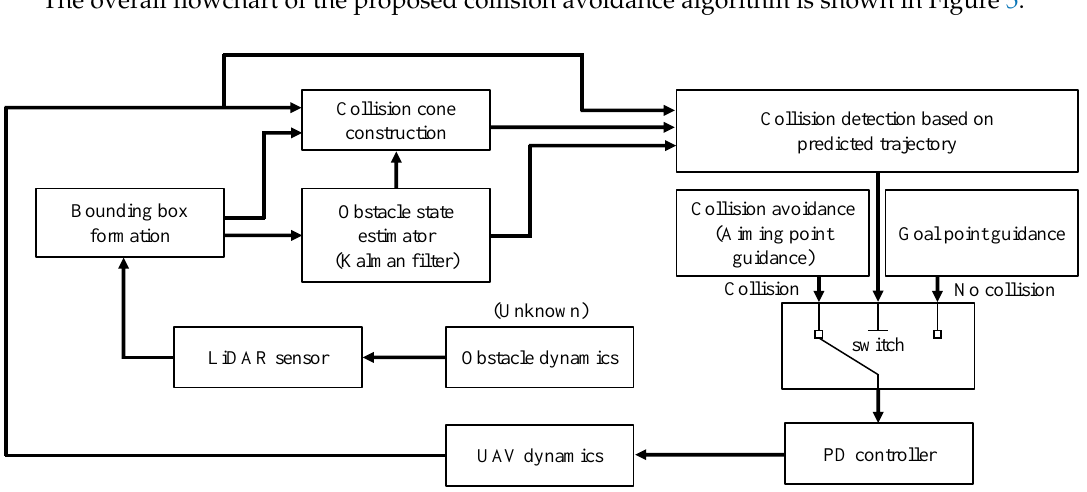
Figure 5. Flowchart of the proposed collision avoidance